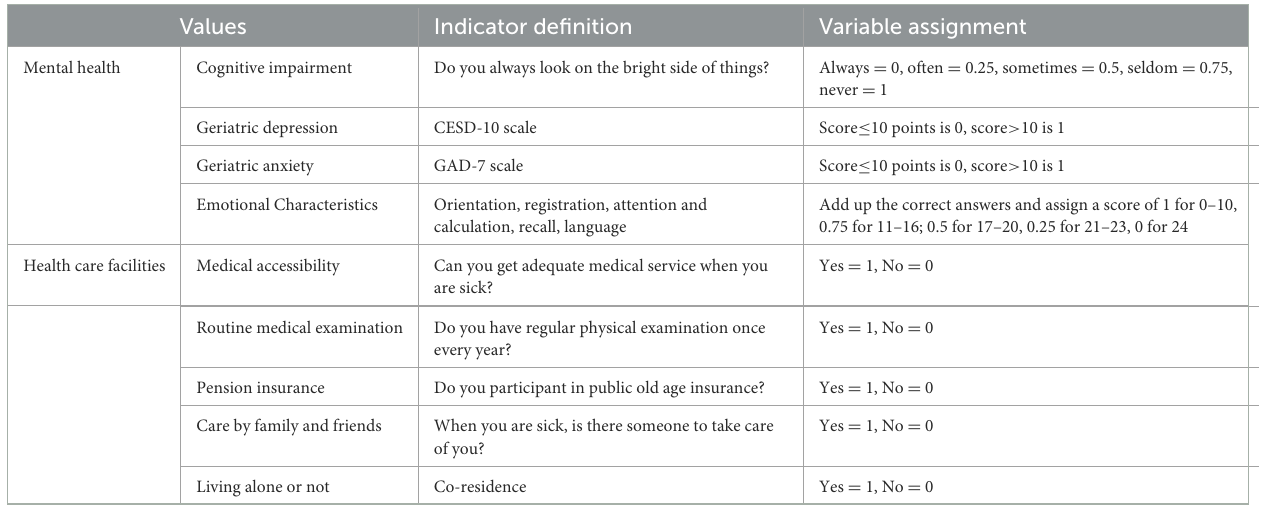
TABLE 3 Indicator definition and